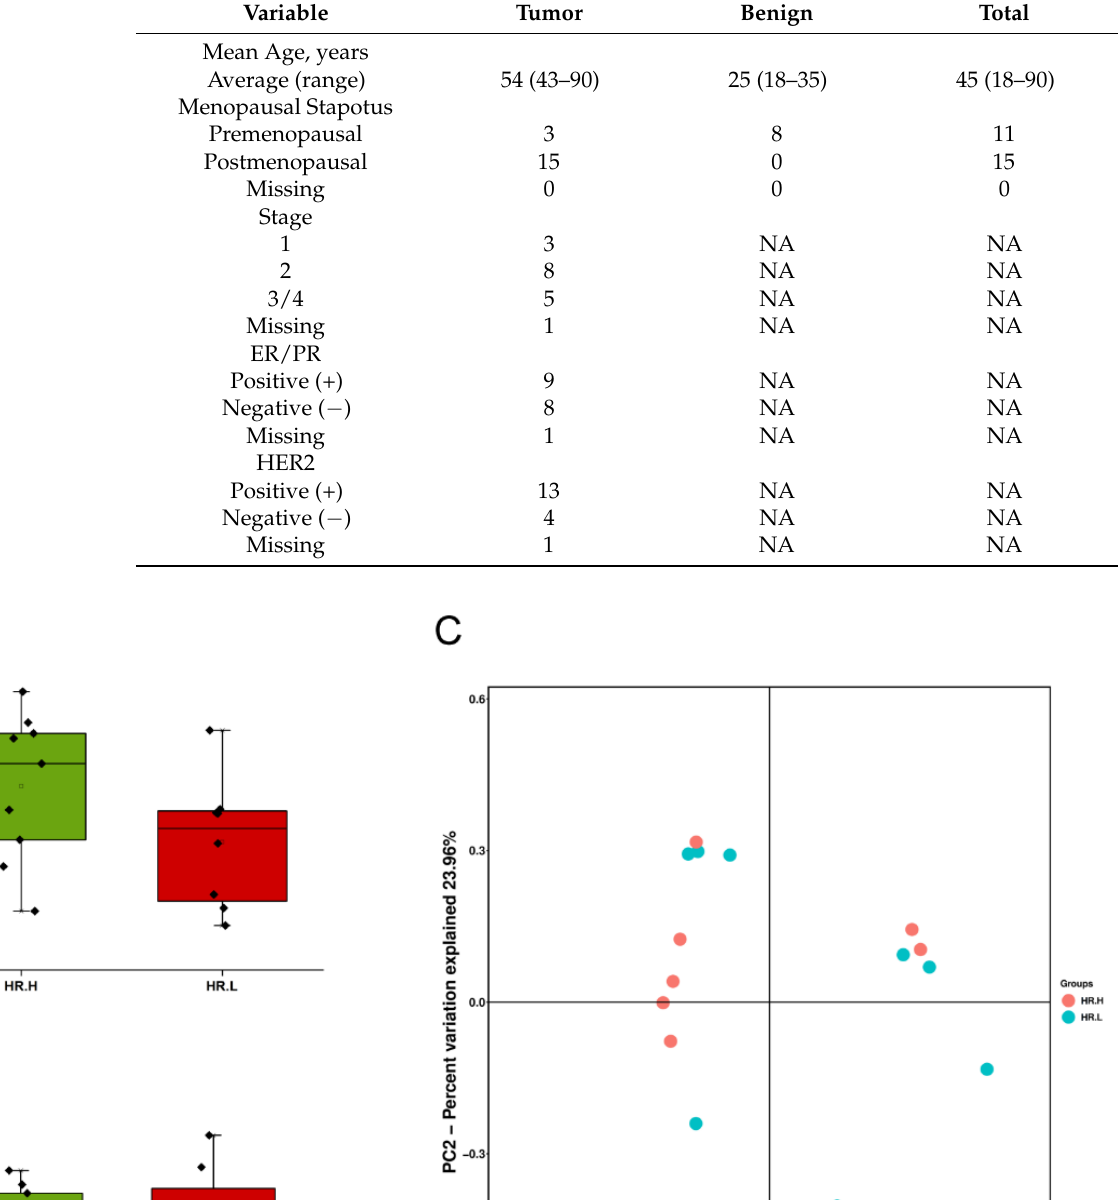
Table 1. Demographics of study patients.